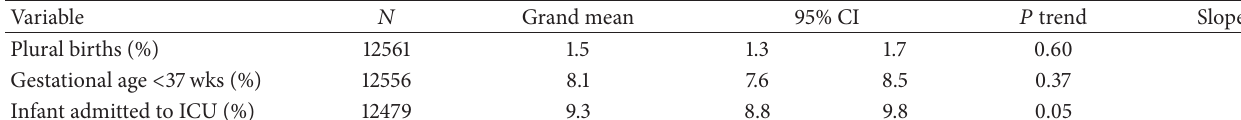
Table 5: Infant outcomes for newborns in Maine, 2000–2010.